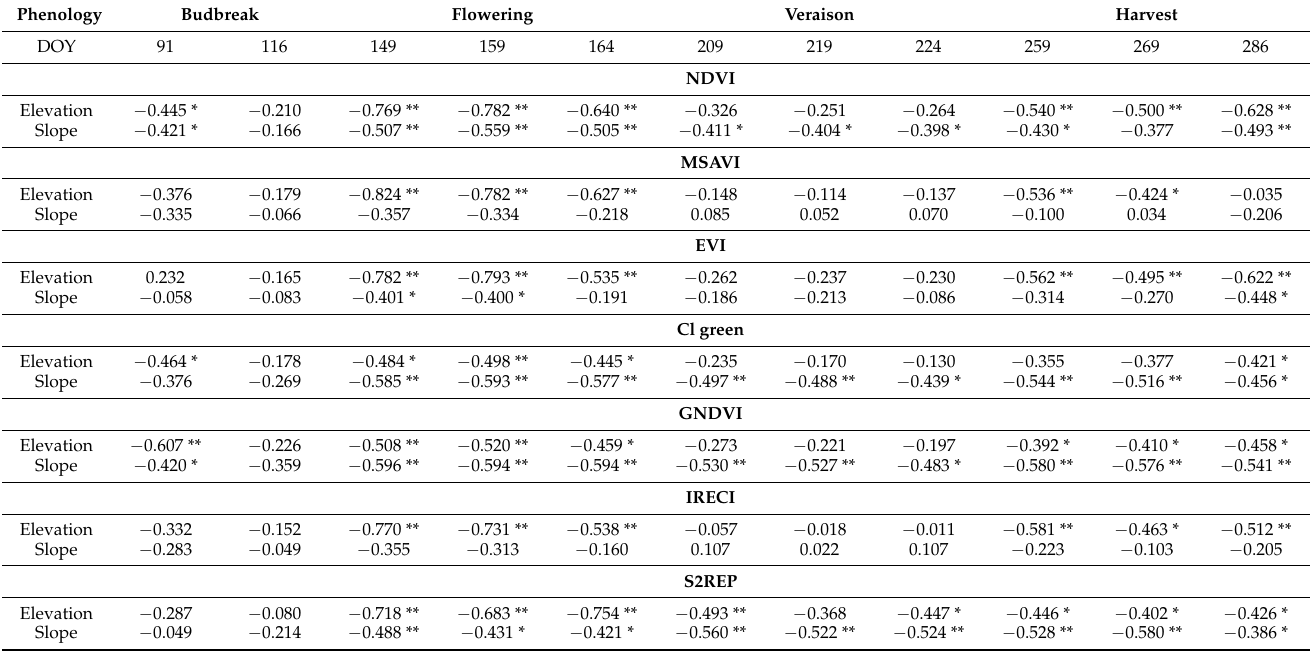
Table 5. Pearson’s correlation matrix for the topographic factors (Elevation, Slope) and